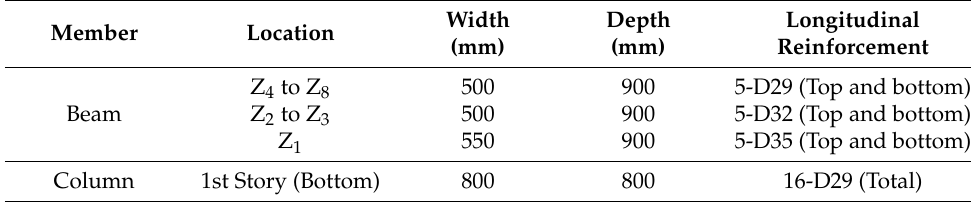
Table A1. Sections at potential hinges of RC members for 8-story model.